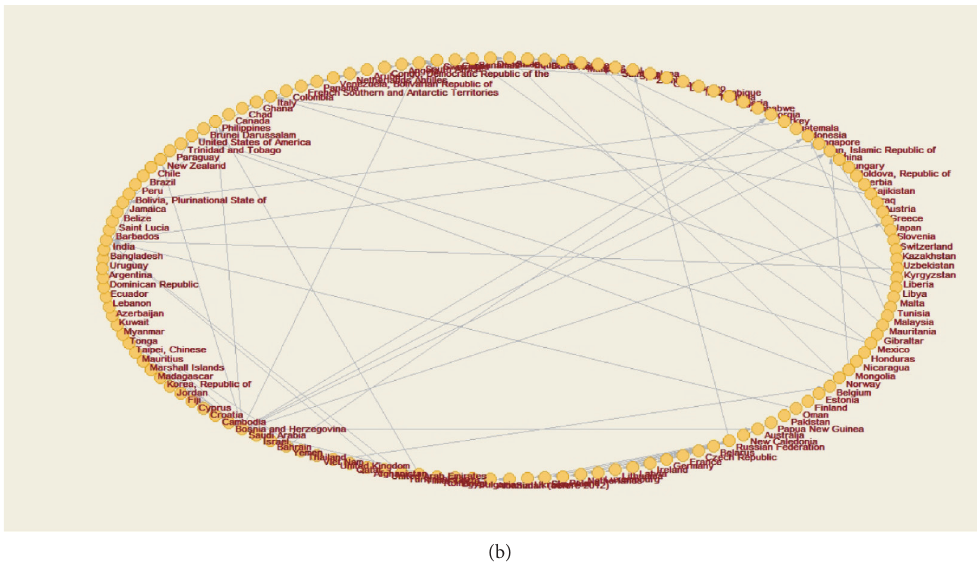
Figure 8: Minimum spanning tree of the global crude oil trading network after optimization: (a) 2010; (b)